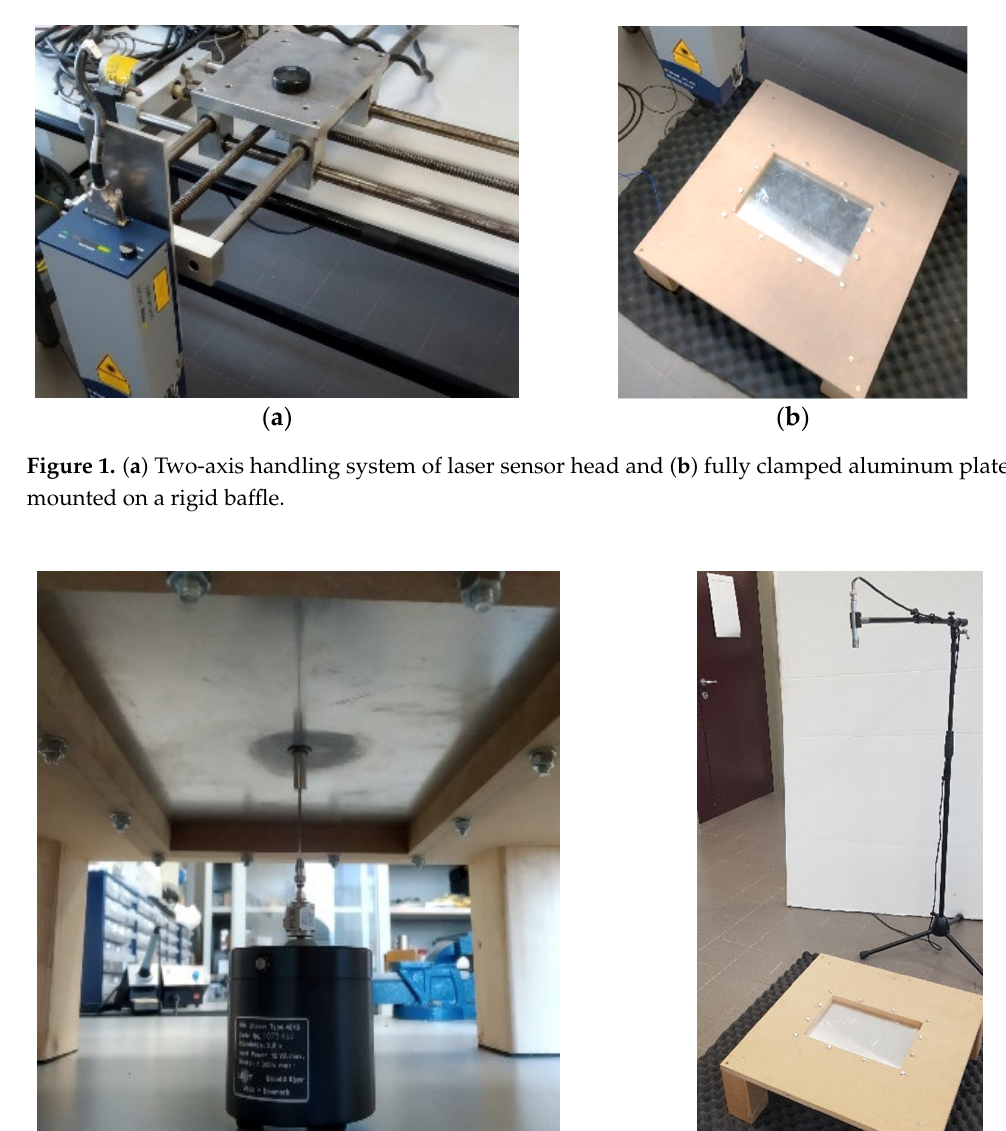
Figure 1. ( a ) Two-axis handling system of laser sensor head and ( b ) fully clamped aluminum plate mounted on a rigid baffle.